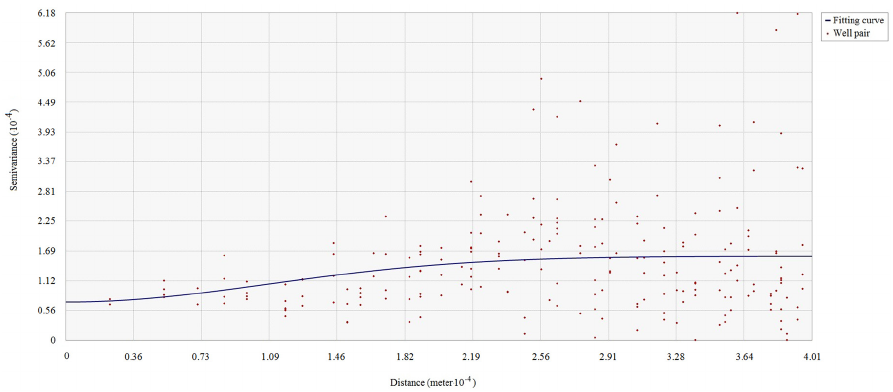
Figure 2. Semi-variogram clouds of the cumulative pore volume in an area.